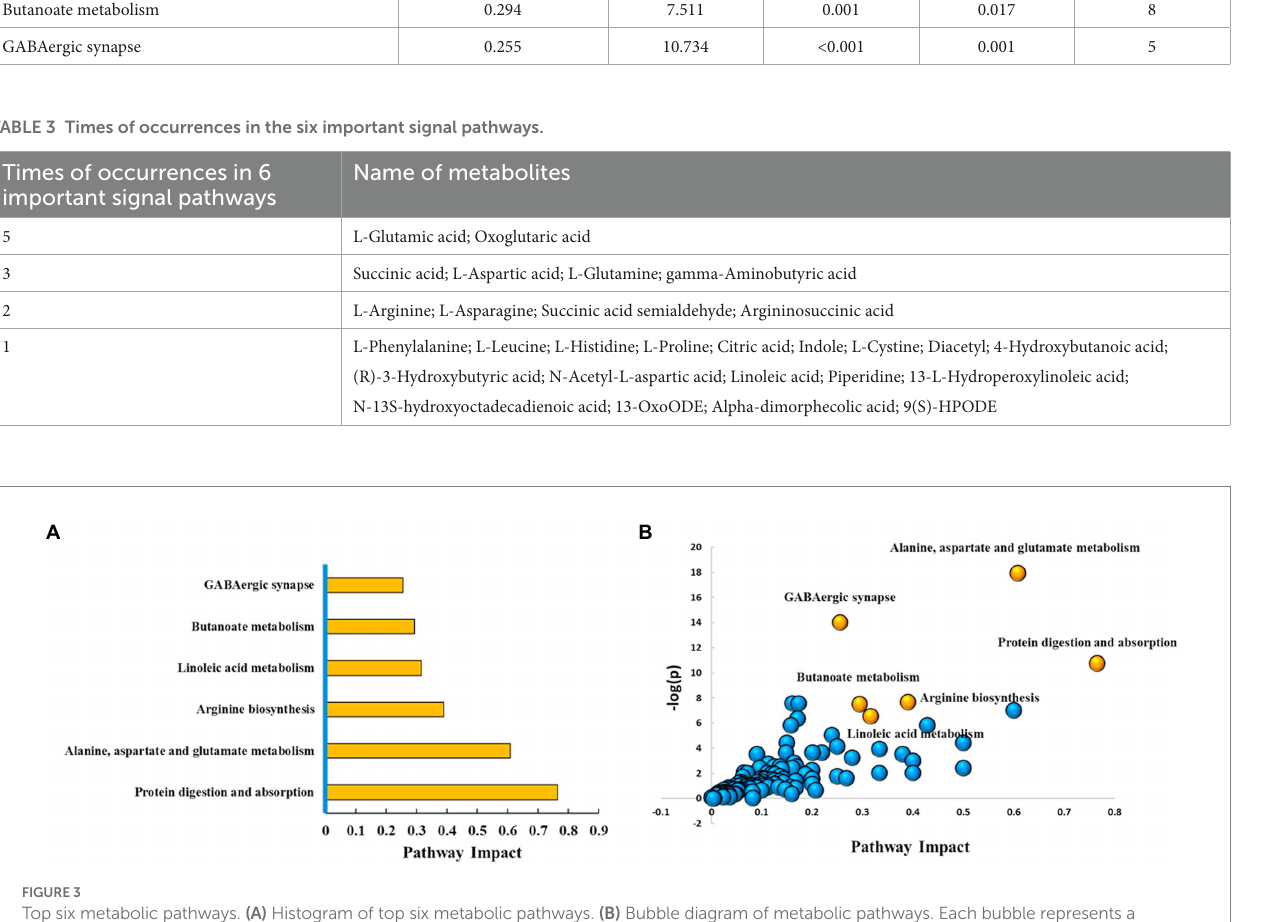
Figure 5. Our analysis results from the validation samples revealed no numerical overlap in the levels of the five screened metabolites between the AD and the control groups, which was consistent with our test results. Thus, these five screened metabolites were considered to be potential diagnostic markers for AD.